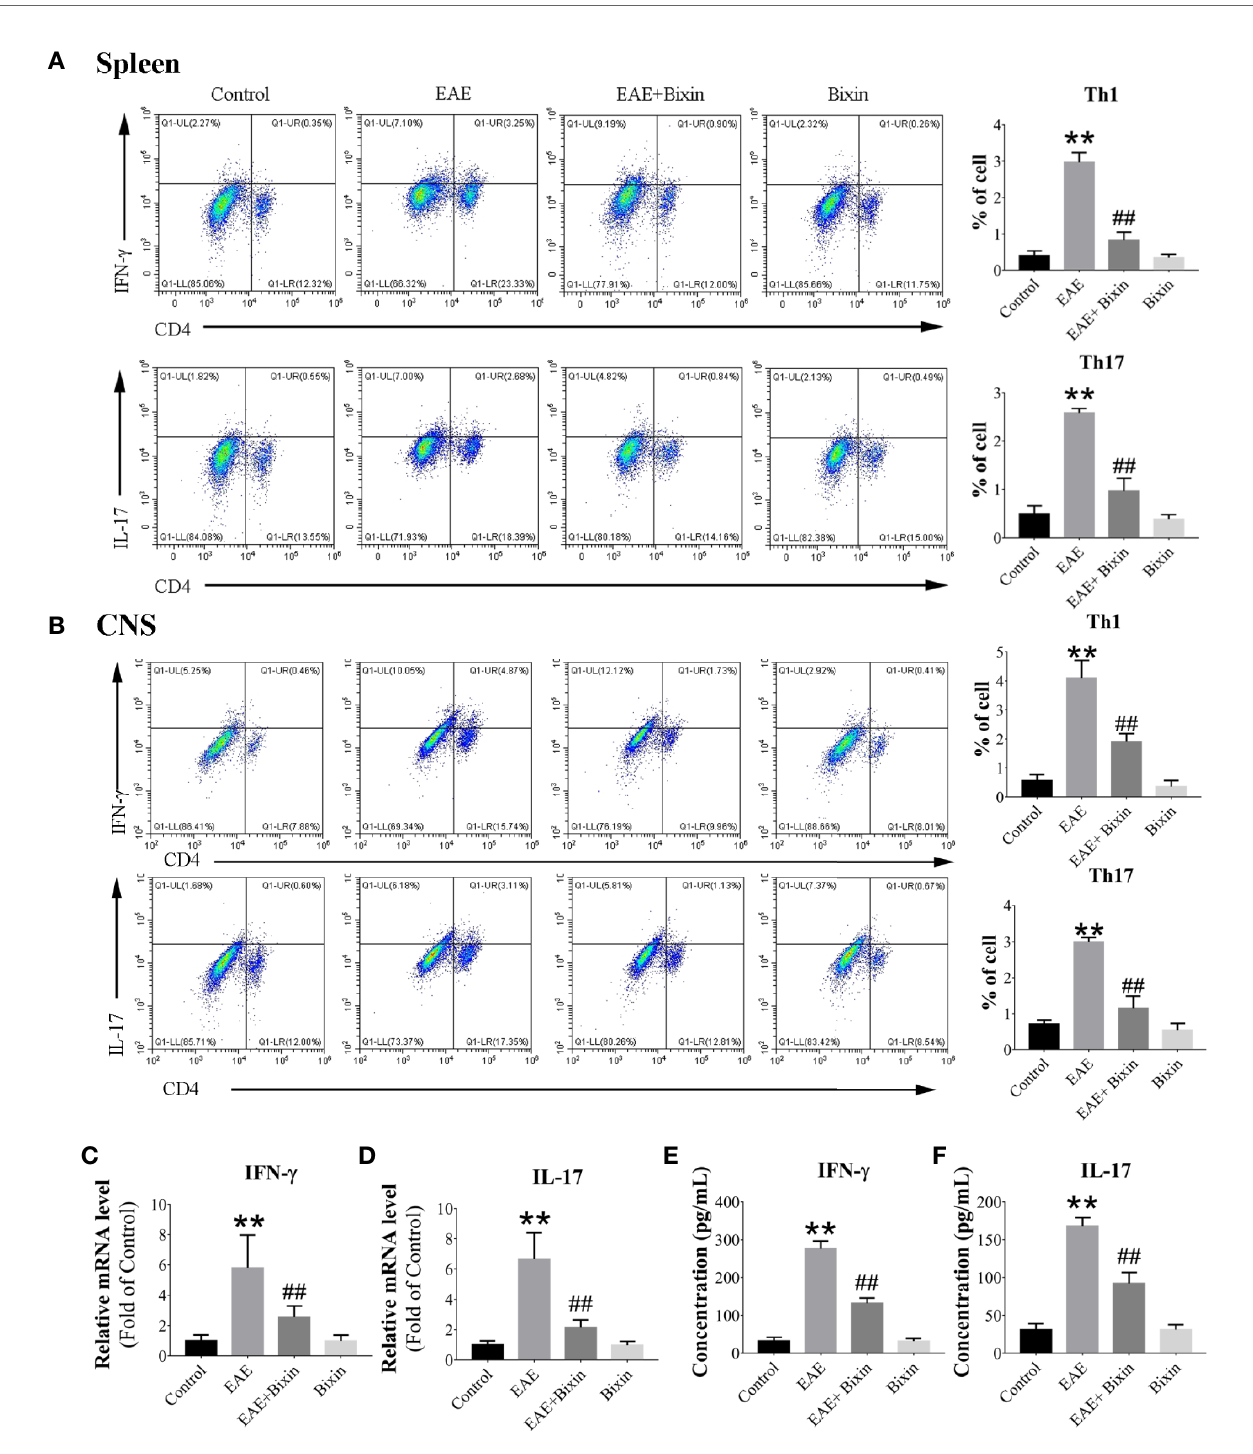
FIGURE 3 | Bixin reduces the proportion of Th1 and Th17 cell subsets. Subsets of Th1 and Th17 cells in CD4+ gate were analyzed by intracellular staining for IFN- g and IL-17, respectively, in MNCs from the spleen (A) and CNS (B) . (C, D) . mRNA expression of the in fl ammatory cytokines IFN- g and IL-17 were quantitated by qRT-PCR (E – F) . IFN- g and IL-17 levels in serum were measured by ELISA. Data shown in graphs represents the means ± SD (n = 5). **P < 0.01, vs. control group; ## P < 0.01, vs. EAE